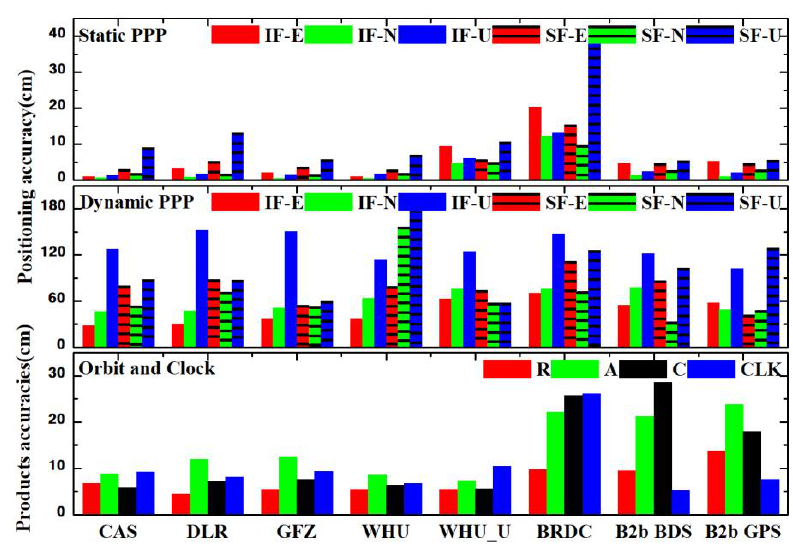
Figure 15. The average accuracy of positioning and real-time products.